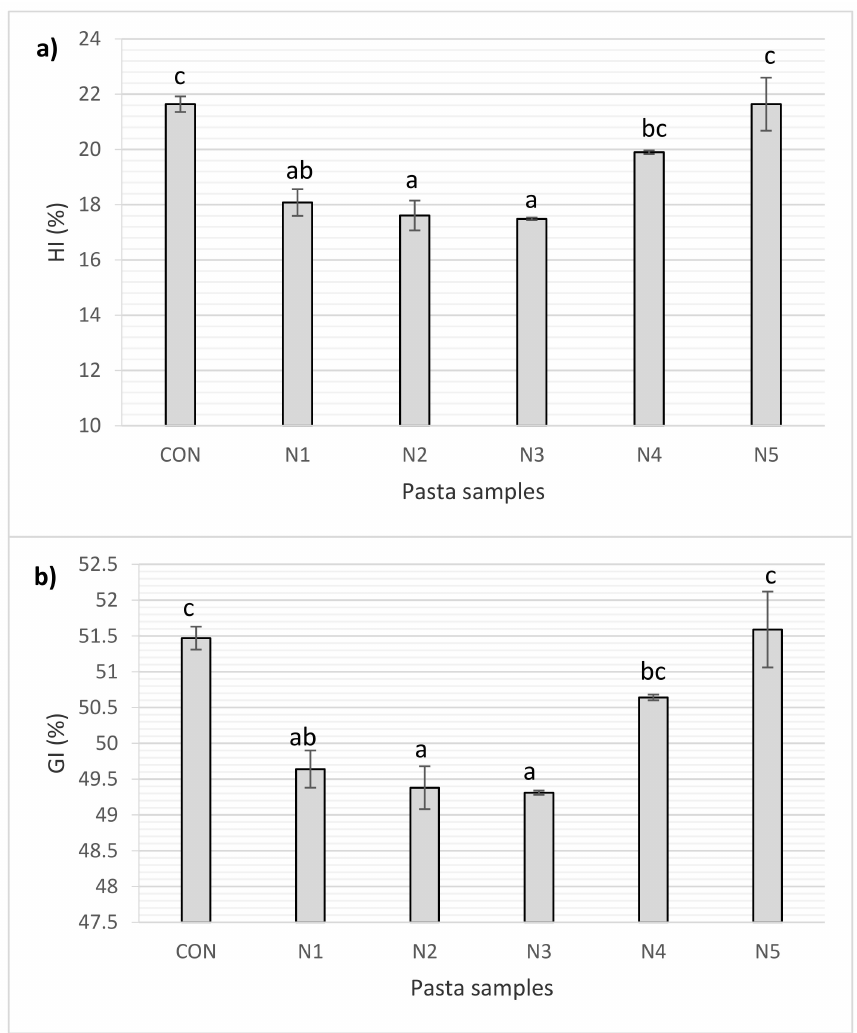
Figure 1. The in vitro starch hydrolysis index ( a ) and glycemic index values ( b ) of pasta. Explanation: HI—hydrolysis index of starch; GI—glycemic index values; CON—control sample; N—pasta with stinging nettle. Data are presented as mean ( n = 2) ± standard deviation. Data values of each parameter with different superscript letters are significantly different (Tukey’s test, p ≤